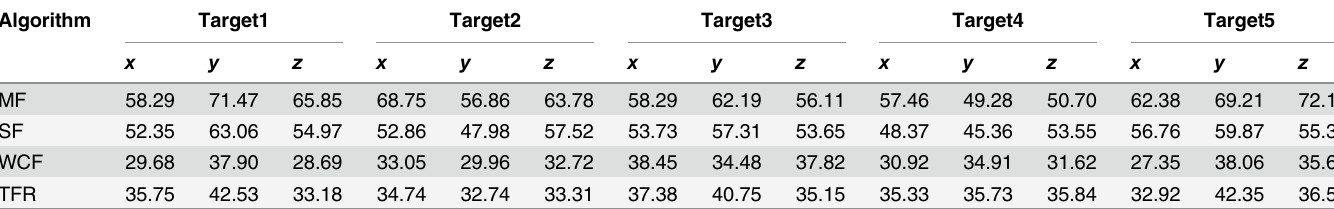
Table 2. Comparisons of average error among MF, SF, WCF and TFR of 5 targets.